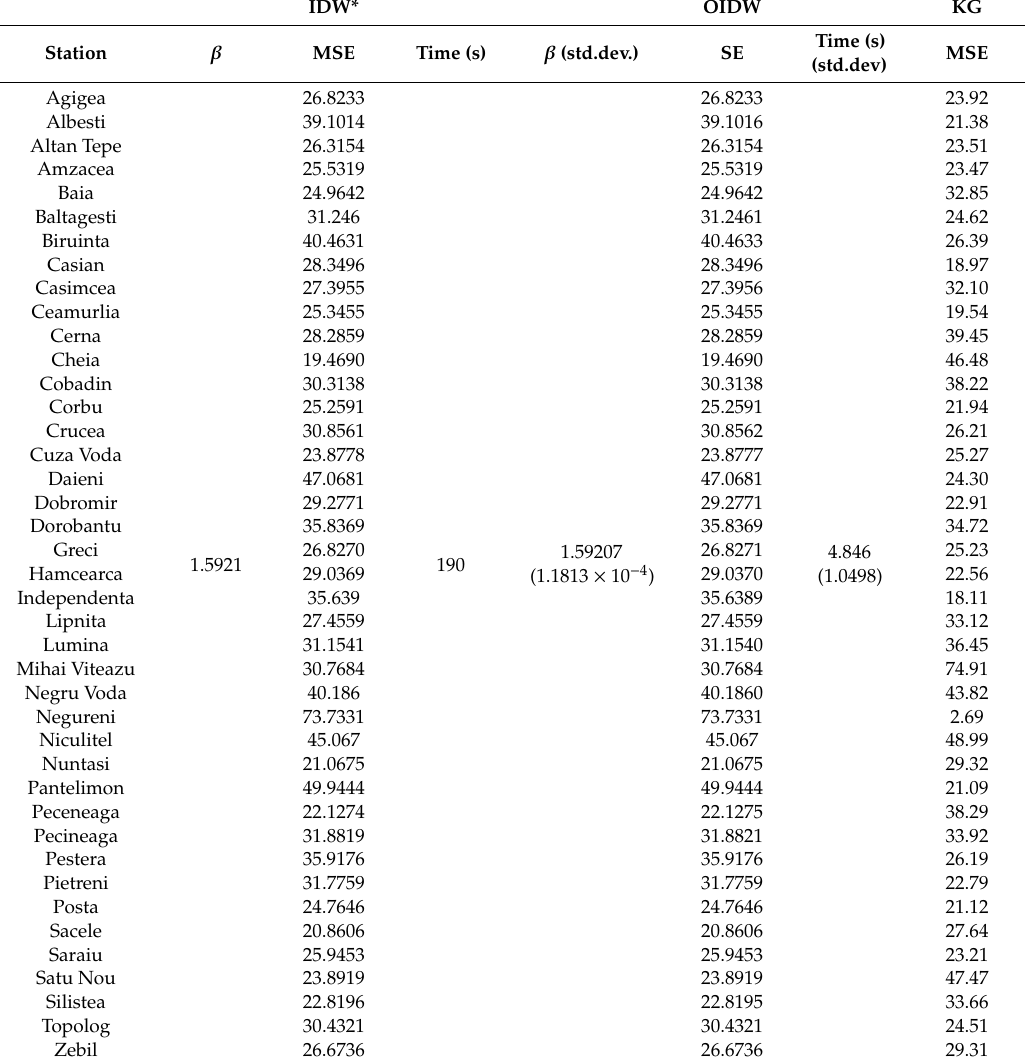
Table 4. Parameter β values obtained in experiments performed using the series recorded at all (51) meteorological stations, in the scenario A2. For OIDW, the values in the parentheses are the standard deviation of the parameter identified, computed over the 50 independent runs. Comparison with KG. IDW* OIDW KG Station β MSE MSE